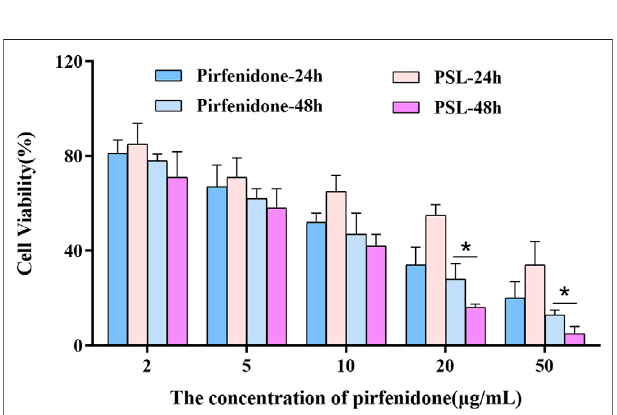
FIGURE 4 | In fl uence of PSLs and pirfenidone on the viability of WI-38 cells after 24 and 48 h (WI-38 cells: The human embryonic lung fi broblast cell line. * p < 0.05, n =